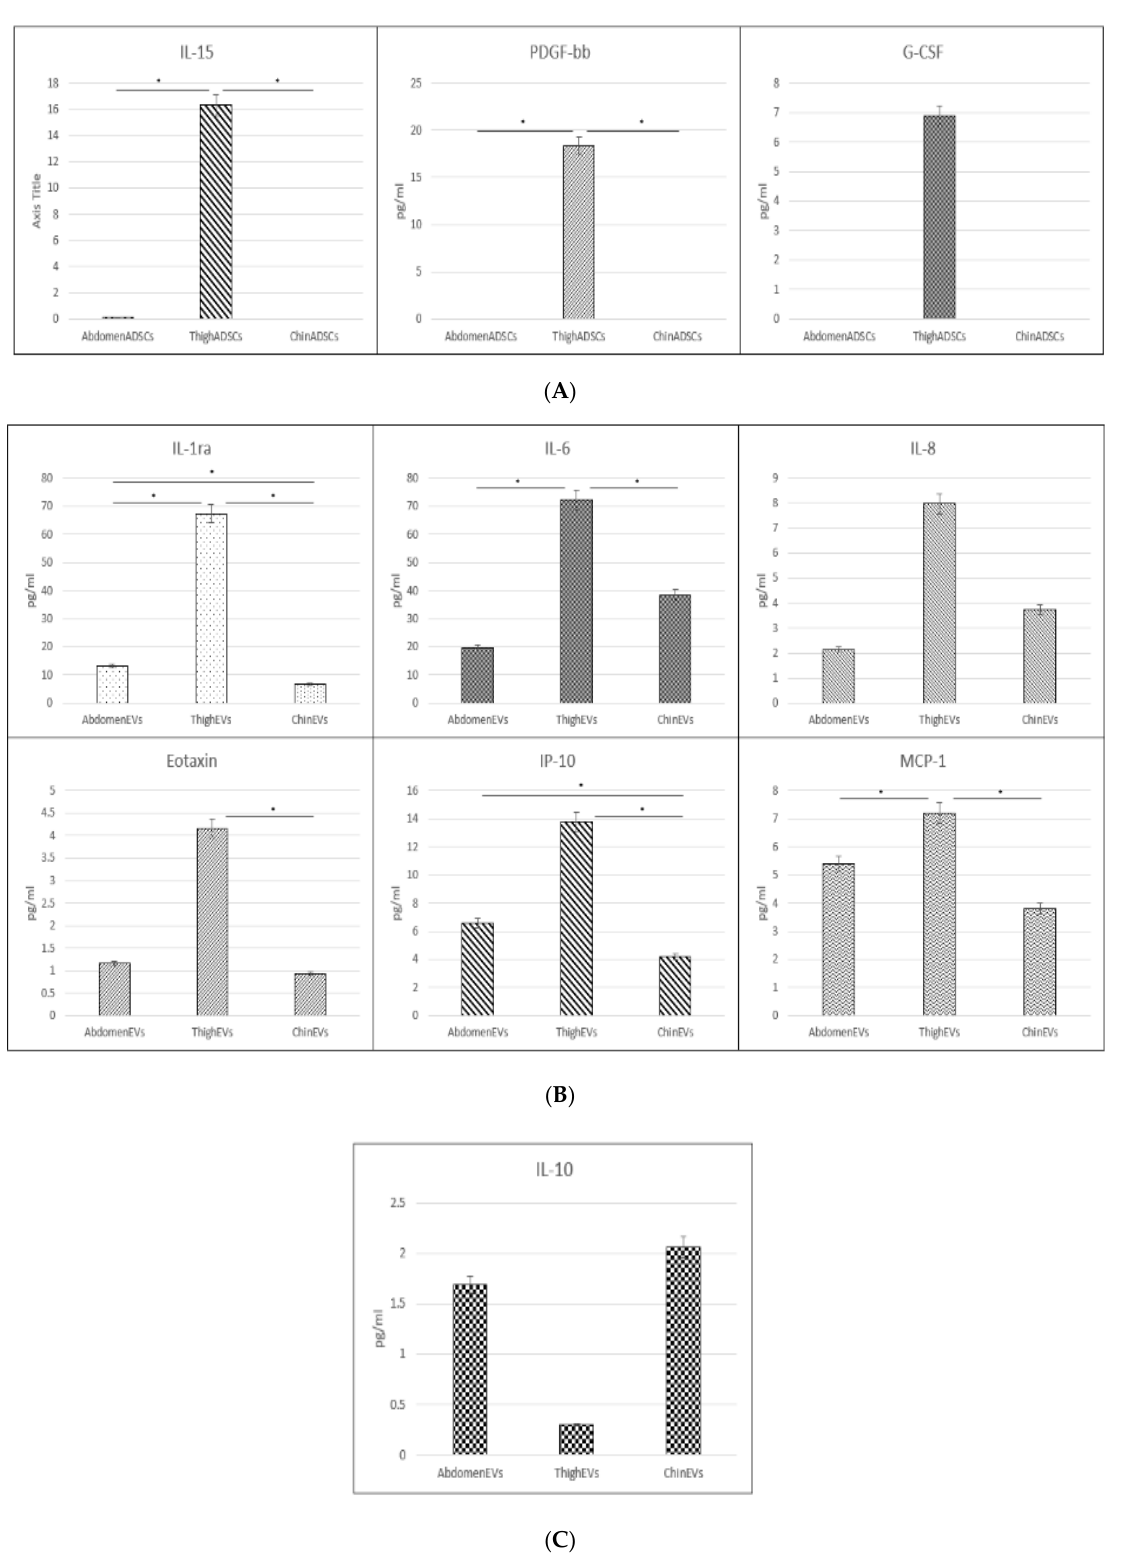
Figure 5. Critical cytokine content comparison graphs: ( A ) ADSC cytokine content of IL-15, PDGF-bb, and G-CSF from ADSCs with the highest measures in thigh ADSCs; ( B ) EV cytokine content for IL-1ra, IL-6, IL8, Eotaxin, IP-10, and MCP-1 with the highest measures in EVs; ( C ) IL-10 content with the highest measure in chin EVs. * p < 0.05 according to Student’s t